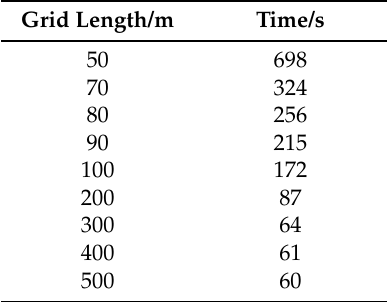
Table 2. Time consuming of implicit surface construction with respect to grid length.